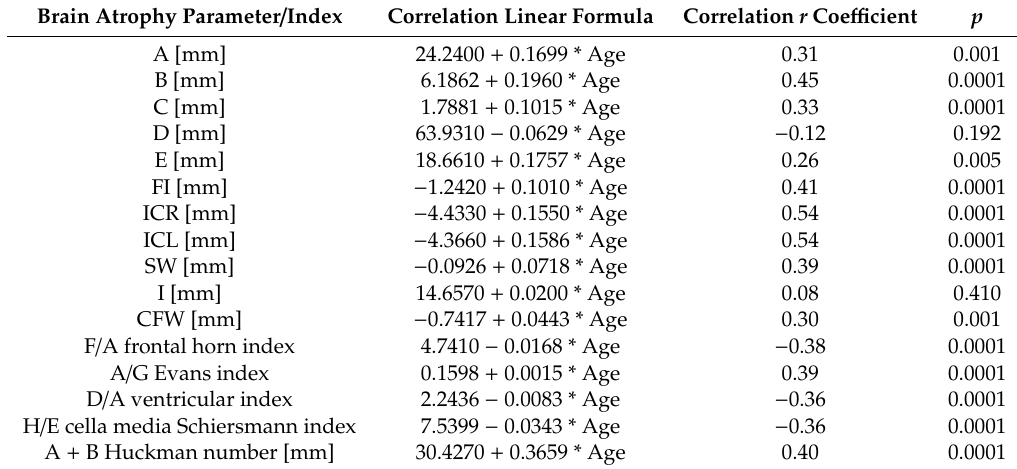
Table 2. Correlations between brain atrophy parameters / indices and age in the group of all the patients aged